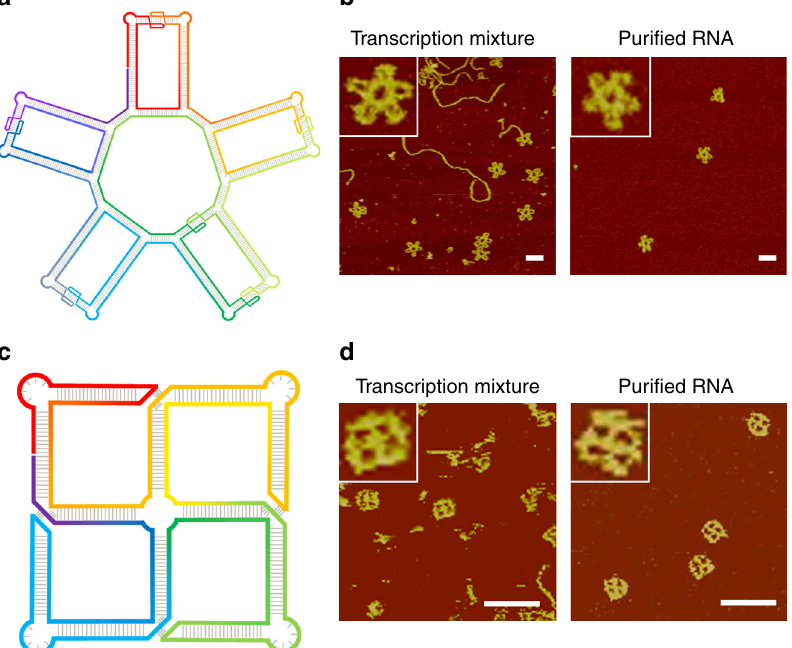
Fig. 3 Folding of complex RNA nanostructures from single RNA strands. a Structural design of an RNA 5-petal fl ower, which contains six KL interactions, ten 90°-kinks, and ten 3WJs. b AFM images of the RNA fl owers. Left: transcription mixture from a PCR mixture. Right: thermal annealed, puri fi ed RNA nano fl ower molecule. Scale of inset: 60 nm. c Structural design of an RNA tetra-square ( S4 ), which contains four 3WLs, four 90°-kinks, and a 4WJ. d AFM images of the RNA S4 . Left: transcription mixture. Right: thermal annealed, puri fi ed RNA S4 . Scale of inset: 25 nm. (Scale bar: 50